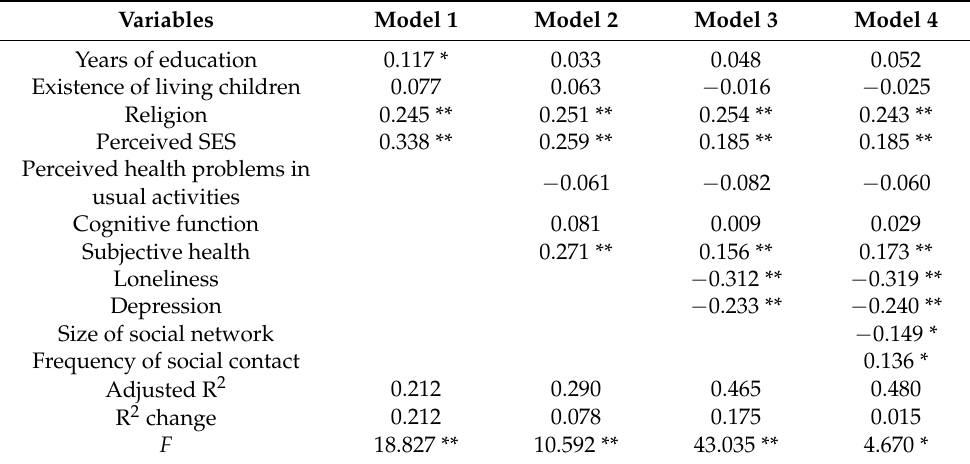
Table 5. Hierarchical regression analysis (Standardized beta